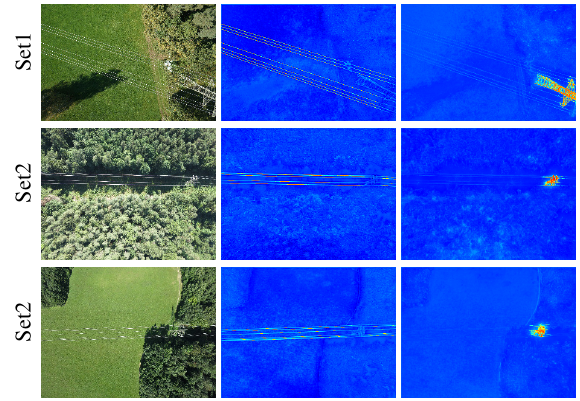
Figure 16. Generalization of semantic segmentation: The first row shows an example of a test image taken from Set1 where the network has been trained on. The further rows show test images from Set2. From left to right we start with the reference RGB image, the probability image for the class power line and the probability image for the class pylon. The warmer the color in the probability images the more likely the pixel belongs to that class. It can be seen that the probability distributions are similar and thus the semantic segmentation generalizes to